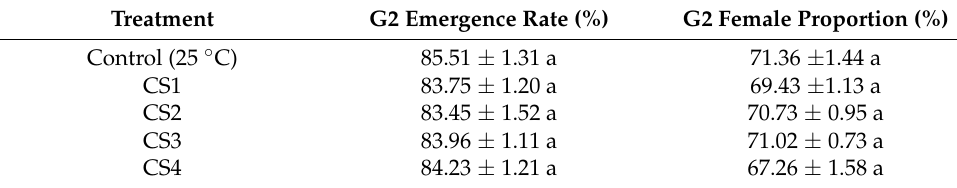
Table 4. Reproductive parameters of G1 P. incisi post-storage adults ( n = 15). Table 5. Emergence rate and female proportion of progeny (G2) ( n = Treatment